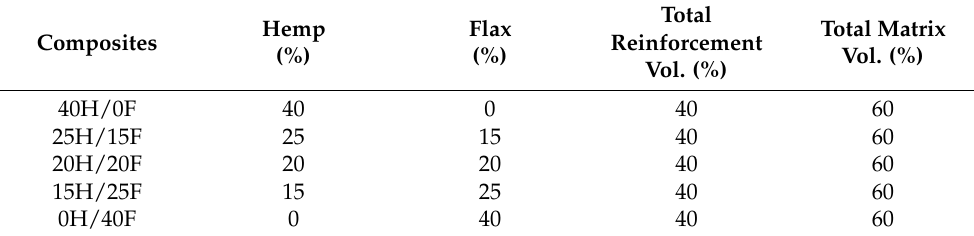
Table 1. The weight fraction of composite samples for epoxy/ecopoxy matrices. Hemp Composites